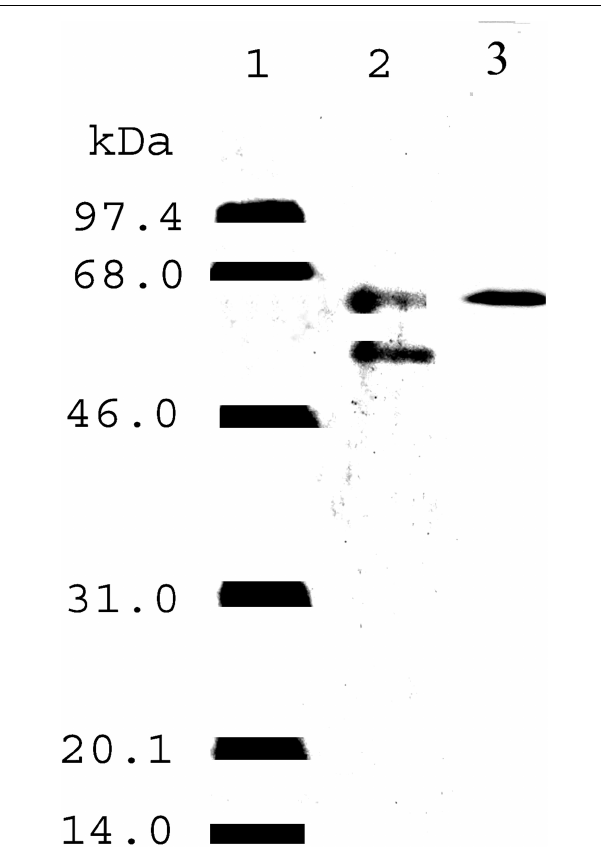
FIGURE 4 |Western blots of human, CSF with antibodies to ERp57 and A β .